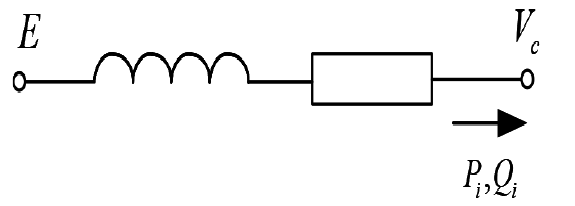
Figure 3. Filter